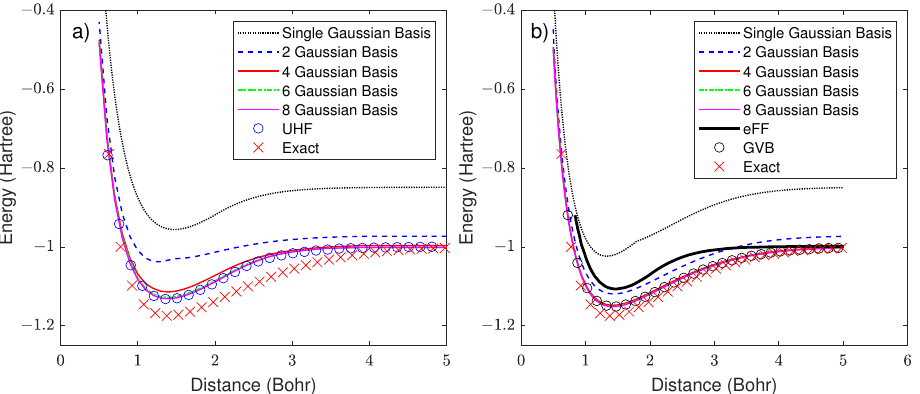
Figure 3. Binding energy of the H 2 molecule. ( a ) VB correction is excluded. Circles represent the unrestricted Hartree–Fock (UHF) solution and crosses represent the exact solution. ( b ) VB correction ( ρ = 1) is included. Circles represent the generalized valence bond (GVB) solution and crosses denote the exact solution. The thick solid line represents the solution obtained using the eFF method.